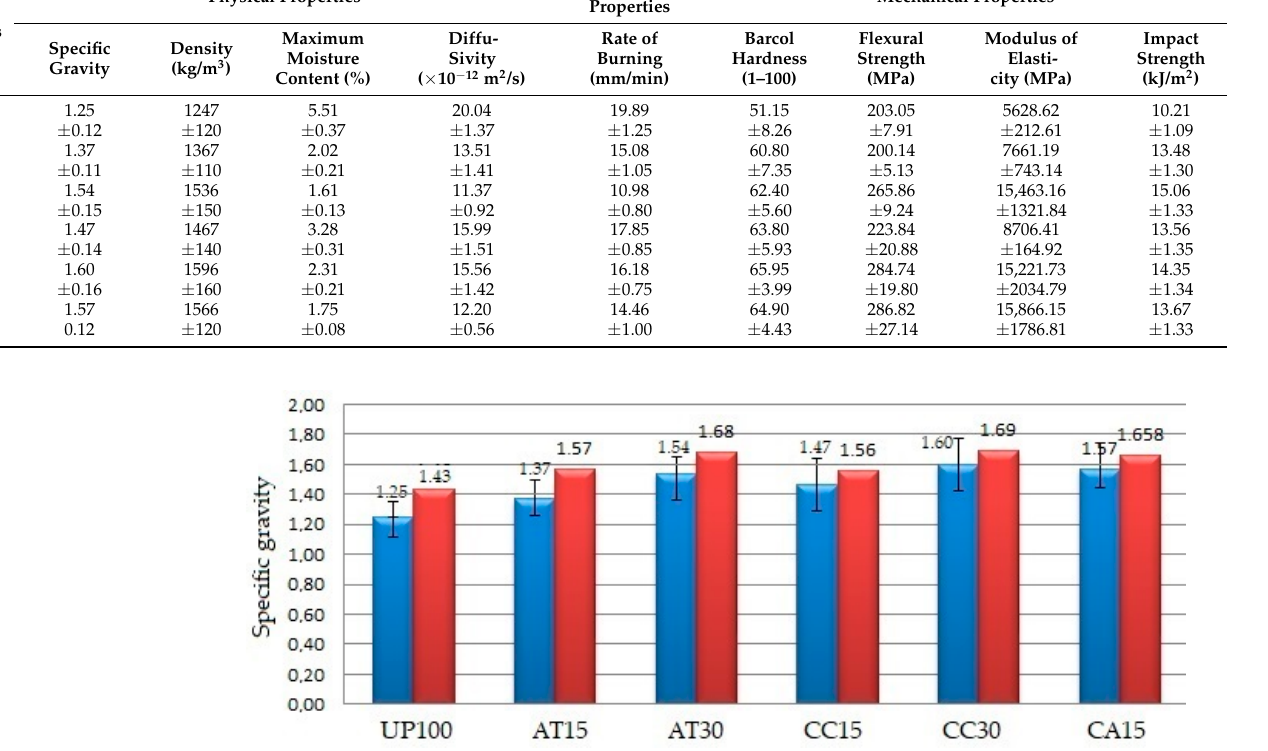
Figure 2. Specific gravity of the GFRP samples.